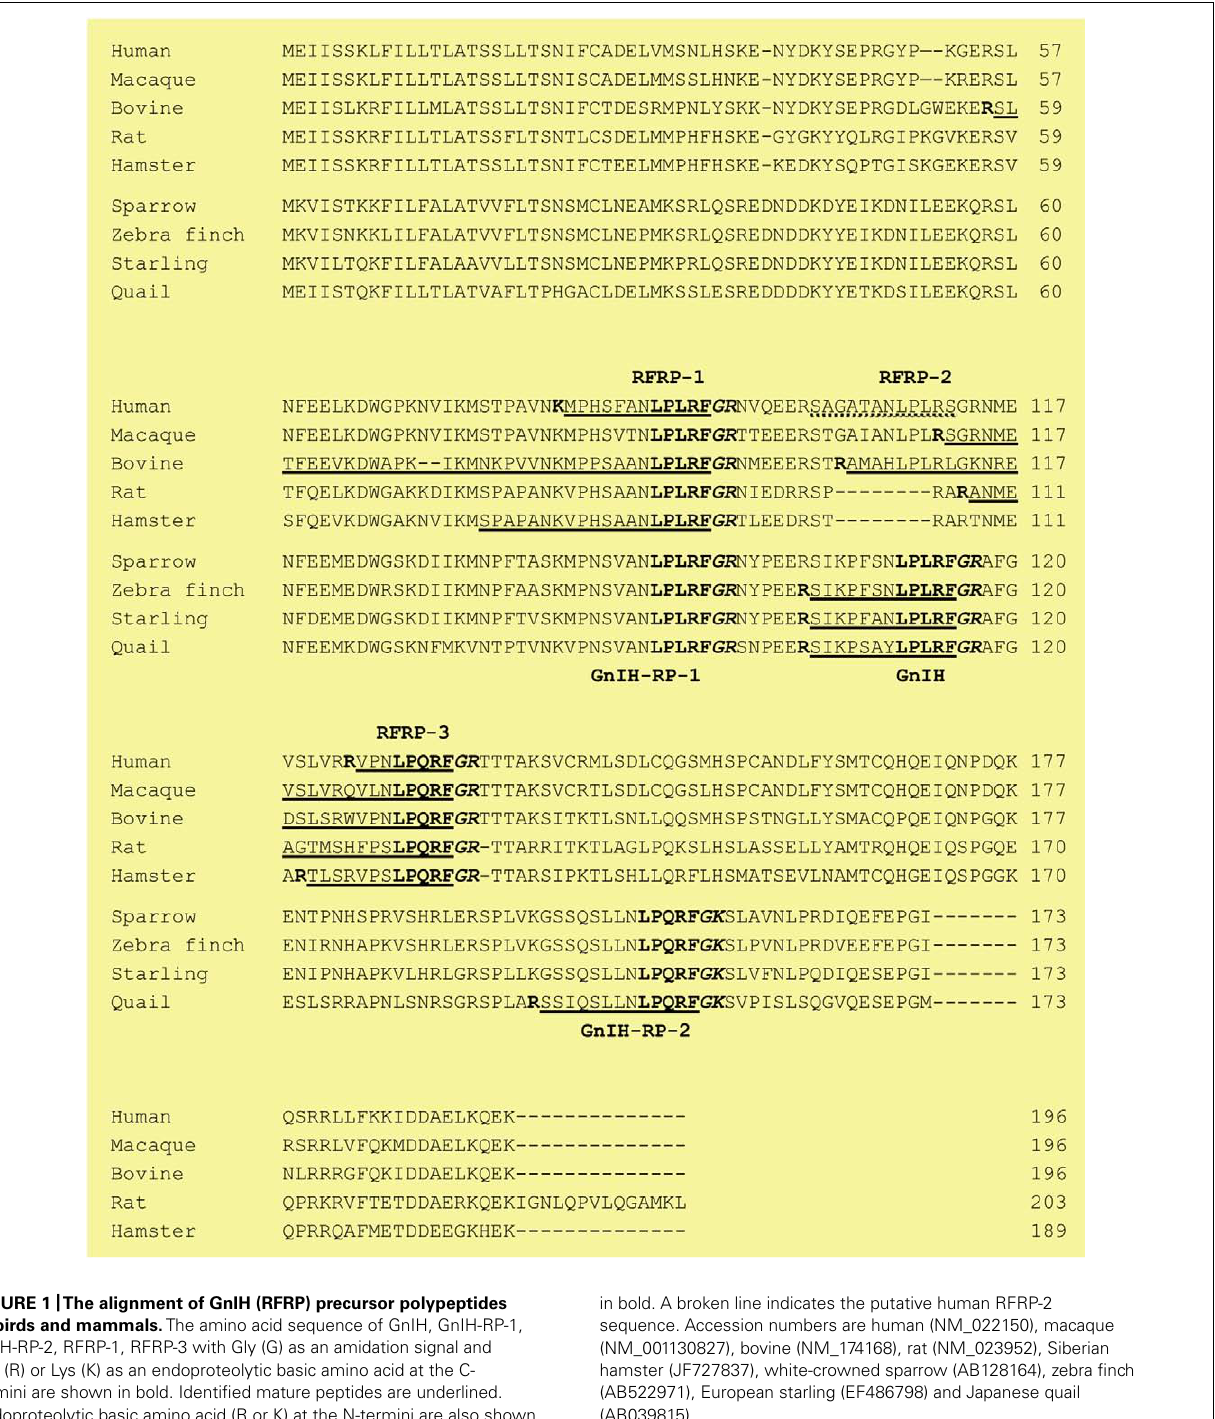
in bold. A broken line indicates the putative human RFRP-2 sequence. Accession numbers are human (NM_022150), macaque (NM_001130827), bovine (NM_174168), rat (NM_023952), Siberian hamster (JF727837), white-crowned sparrow (AB128164), zebra finch (AB522971), European starling (EF486798) and Japanese quail